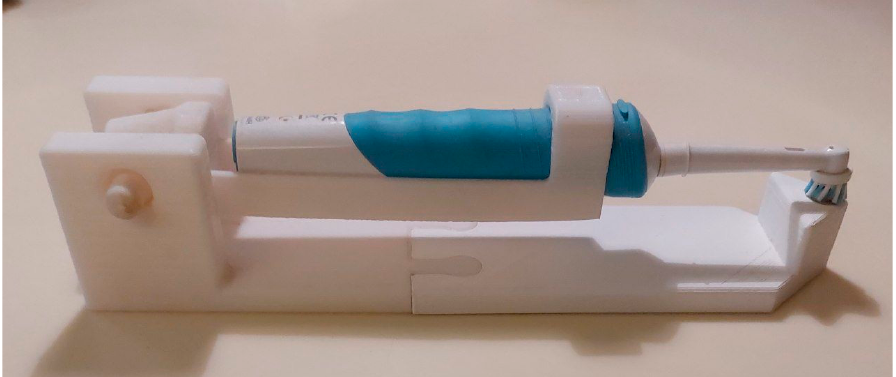
Figure 3. The 3D-printed experimental brushing machine.